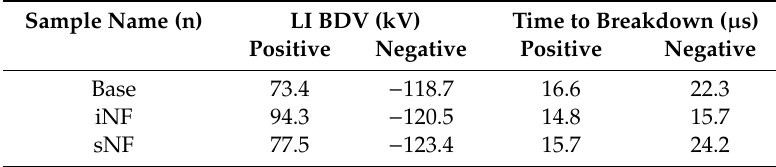
Table 6. Mean positive and negative LI BDVs and time to breakdown.